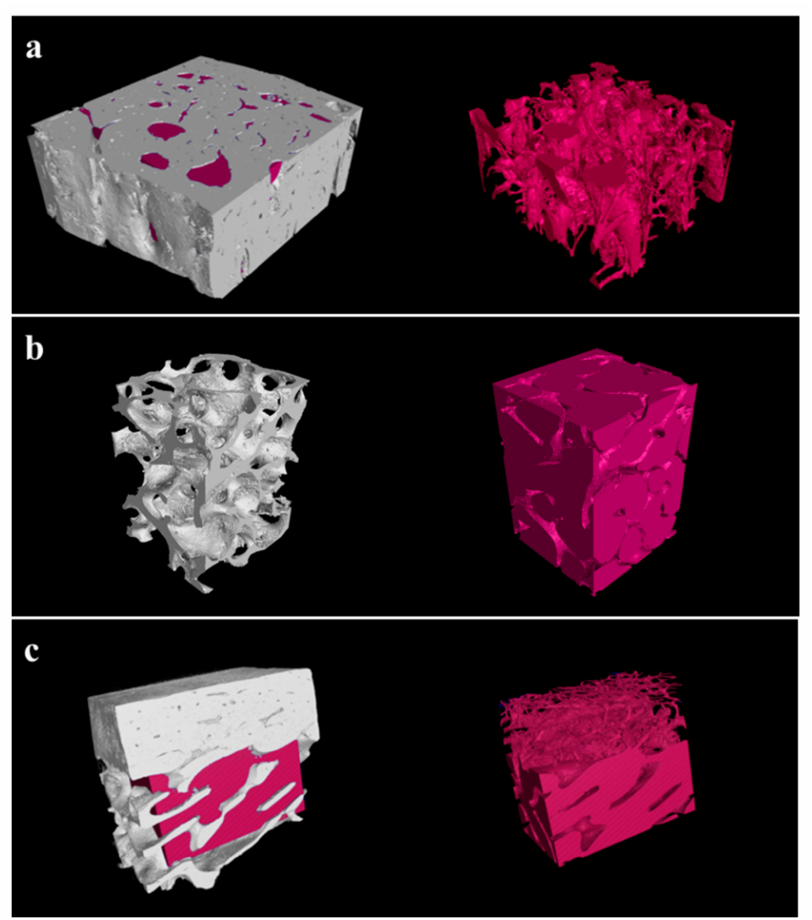
Figure 3. Three-dimensional porosity images of experimental groups. ( a ) Cortical, ( b ) Cancellous, and ( c ) 2layer bone